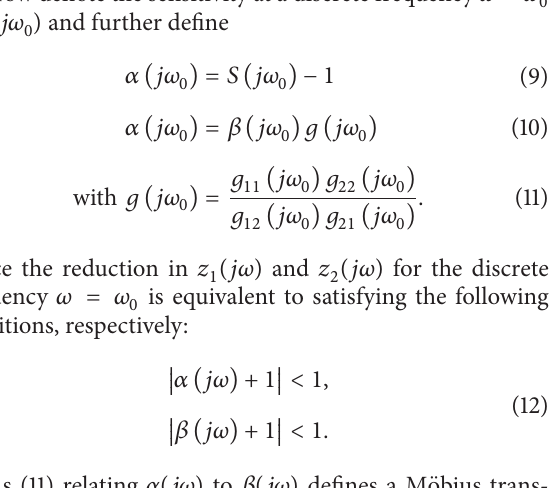
Figure 2: The suspension catenary in a single span.